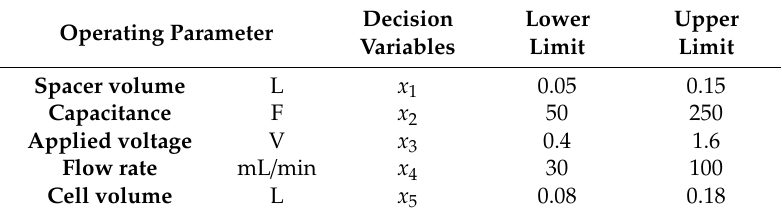
Table 3. Lower and upper bounds of the CDI operating parameters used during optimization, already reported in